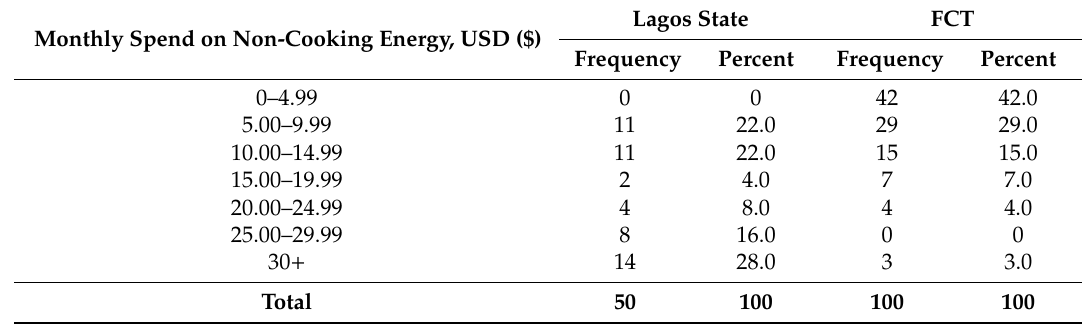
Table 4. Household monthly spend on non-cooking energy across both locations. Monthly Spend on Non-Cooking Energy, USD